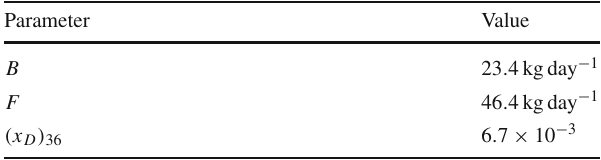
Table5 McCabe–Thielemethod:outputparametersfor 36 Ar– 40 Ardis- tillation in a run with atmospheric argon. Feed, F , and bottom, B , mass flowrates of the feed argon, and mass fraction of 36 Ar in the top distil- late, ( x D ) 36 . The calculation was performed requiring the 36 Ar isotopic fraction, i.e. x B / x F , to be reduced by a factor of 1000